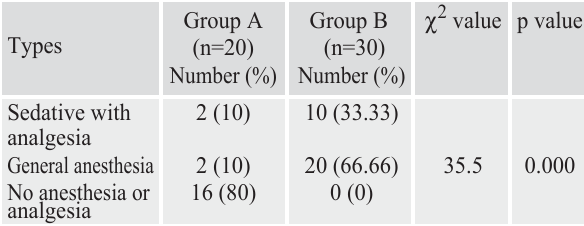
Table III: Types of anesthesia and/or analgesia used